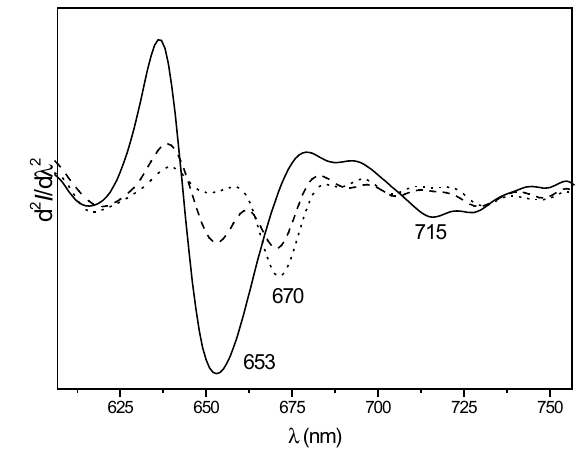
Figure 4. Second derivative curves calculated from smoothed emi- sion spectra of meso-tetrakis(4-sulfonatophenyl)porphine of representative LDH2 formamide